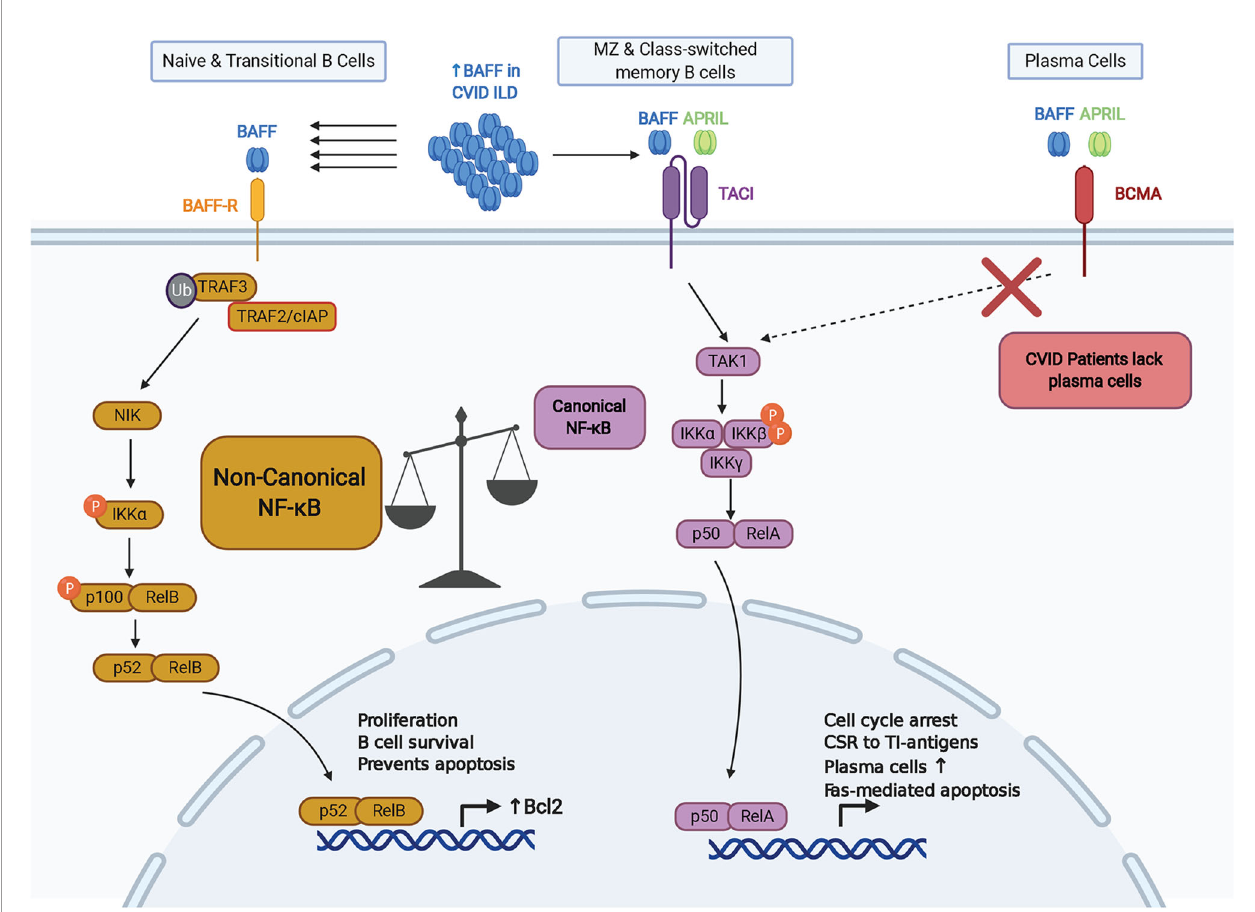
FIGURE 1 | Key aspects of BAFF-R, TACI, and BCMA signaling within the context of CVID. BAFF-R is distinguished by its ability to signal via the non-canonical NF- kB pathway to induce Bcl-2 and other pro-survival factors. Lack of memory B cells and plasma cells expressing TACI and BCMA in CVID may increase signaling via BAFF-R. CSR, class-switch recombination; TI,